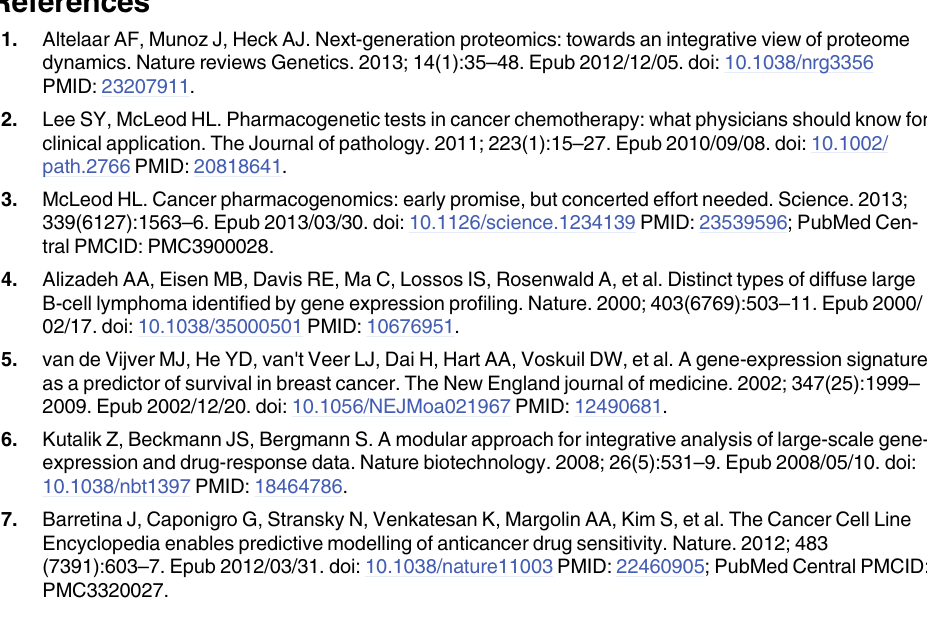
S1 Table. Potential subtypes considered as split in CCLE-Blood. S2 Table. Summary of datasets. S3 Table. Features selected for CCLE-SkinGlioma. S4 Table. Features selected for CCLE-BreastOvary. S5 Table. Features selected for